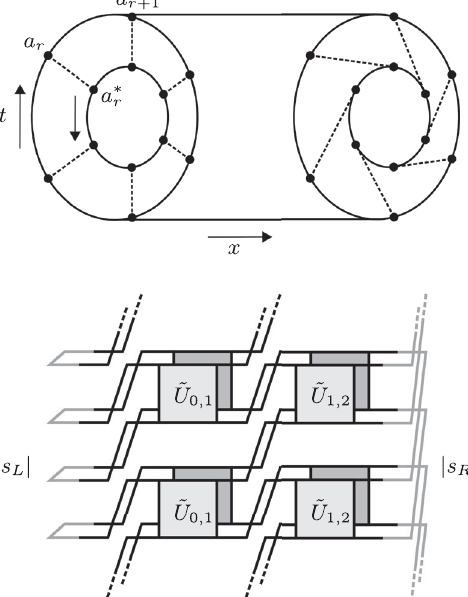
FIG. 12. Twisted boundary conditions on a pair of forward and backward orbits, Z ð s; t Þ . At the top, we show the two orbit pairings of Fig. 2 imposed on the left and right sites, s L ¼ 0 and s ¼ 1 , so s ¼ s − s ¼ 1 . Below this, we show Z ð 1 ; 2 Þ for R R L L ¼ 3 sites in terms of the transfer matrices T for bonds (0,1) and (1,2), Z ð 1 ; 2 Þ ¼ h s L ¼ 0 j T 0 ; 1 ð 2 Þ T 1 ; 2 ð 2 Þj s R ¼ 1 i . The states h s L j and j s R i are represented by gray